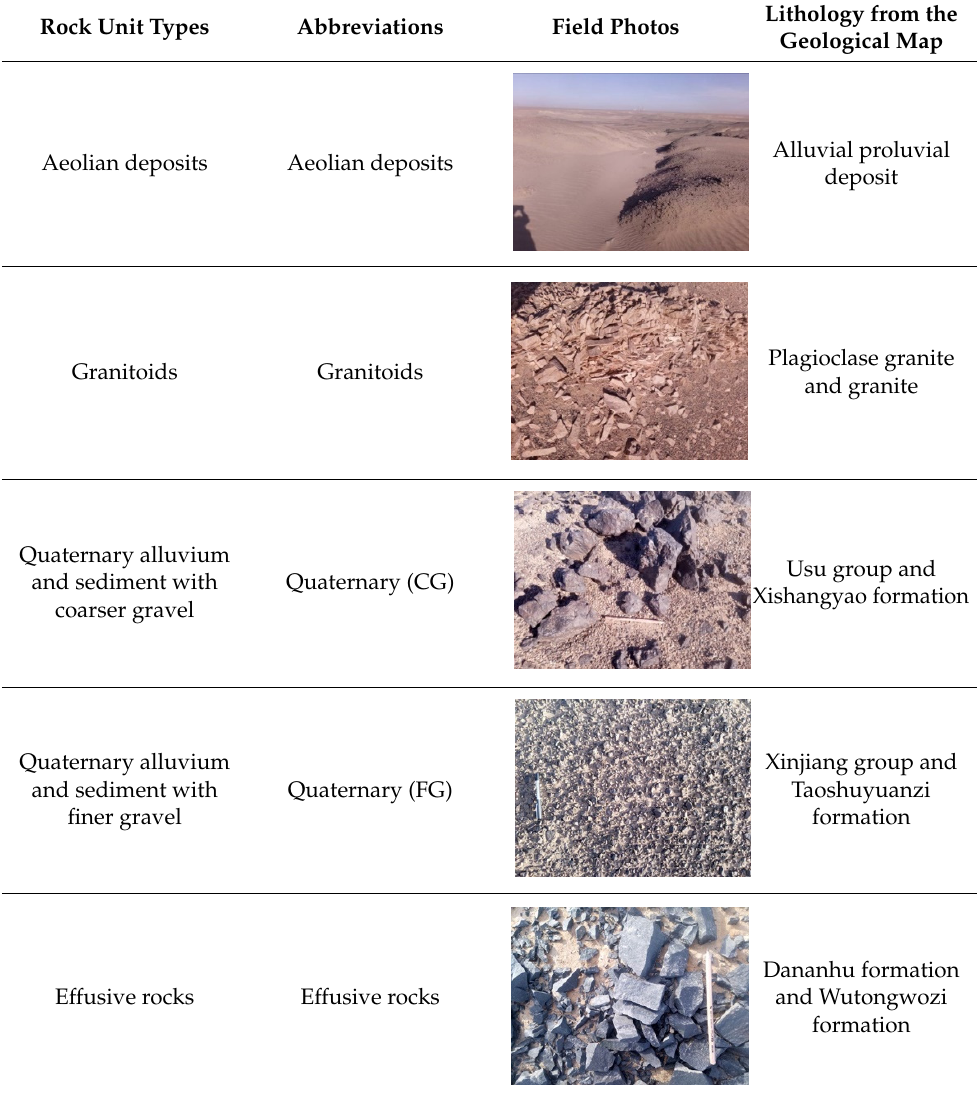
Table 1. Rock unit types, field photos, and lithology in the geological map.